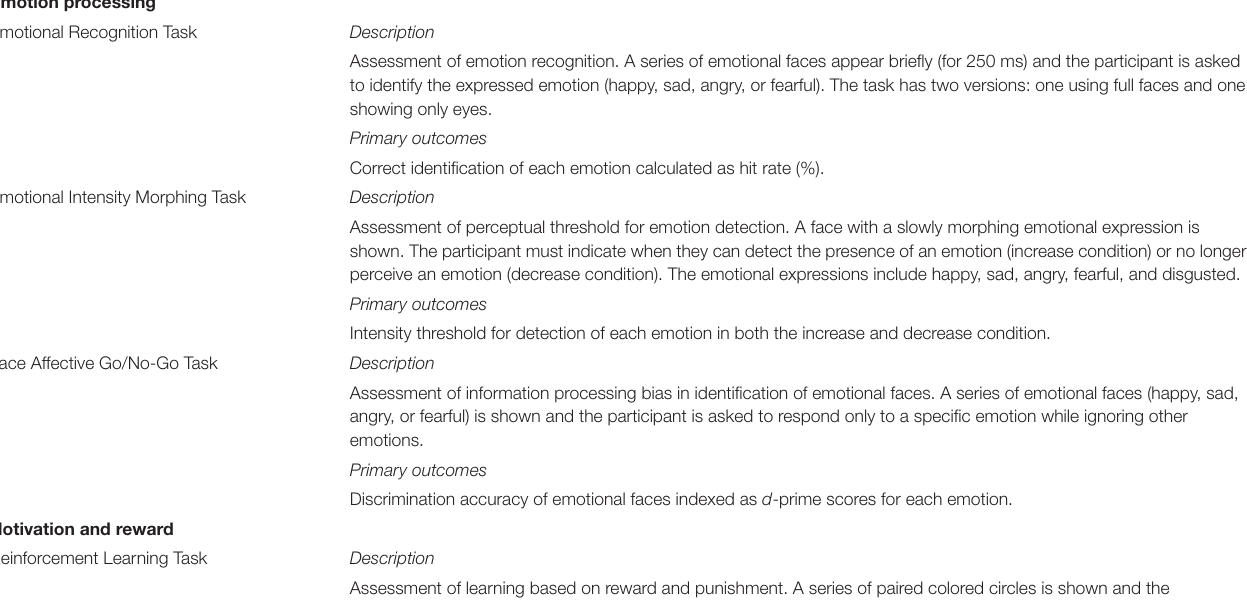
TABLE 1 | EMOTICOM task overview. Emotion processing Emotional Recognition Task